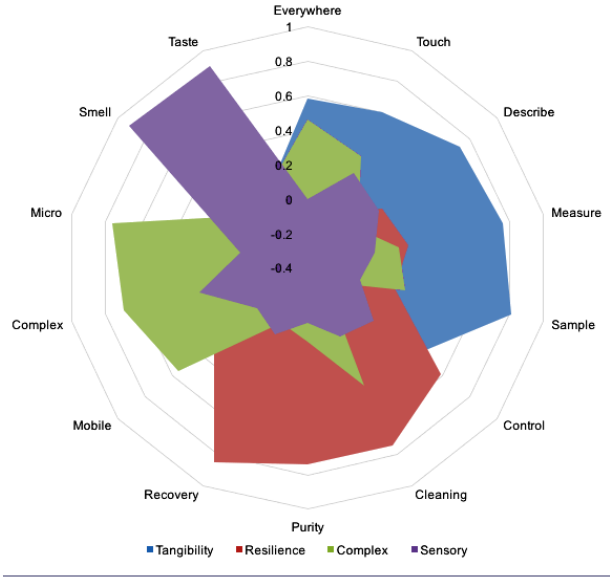
Fig. 1 . Principal components analysis factor space. The PCA factor space shows the “perceptual map” of how people conceive of the environment, defined here by its most coarse scale raw materials: air, water, and soil. We show that although overlaps exist (which is expected when measuring a complex topic), four distinct factors emerge: resilience, tangibility, complex, and sensory. The average loadings summarize the items (listed on the outer ring of the space), which make up each factor. For an item to be included in a factor it had to have a loading of greater than 0.5. Within the solution, resilience (25%) and tangibility (33%) factors explain more of the variance than do the complex (23%) or sensory (20%)